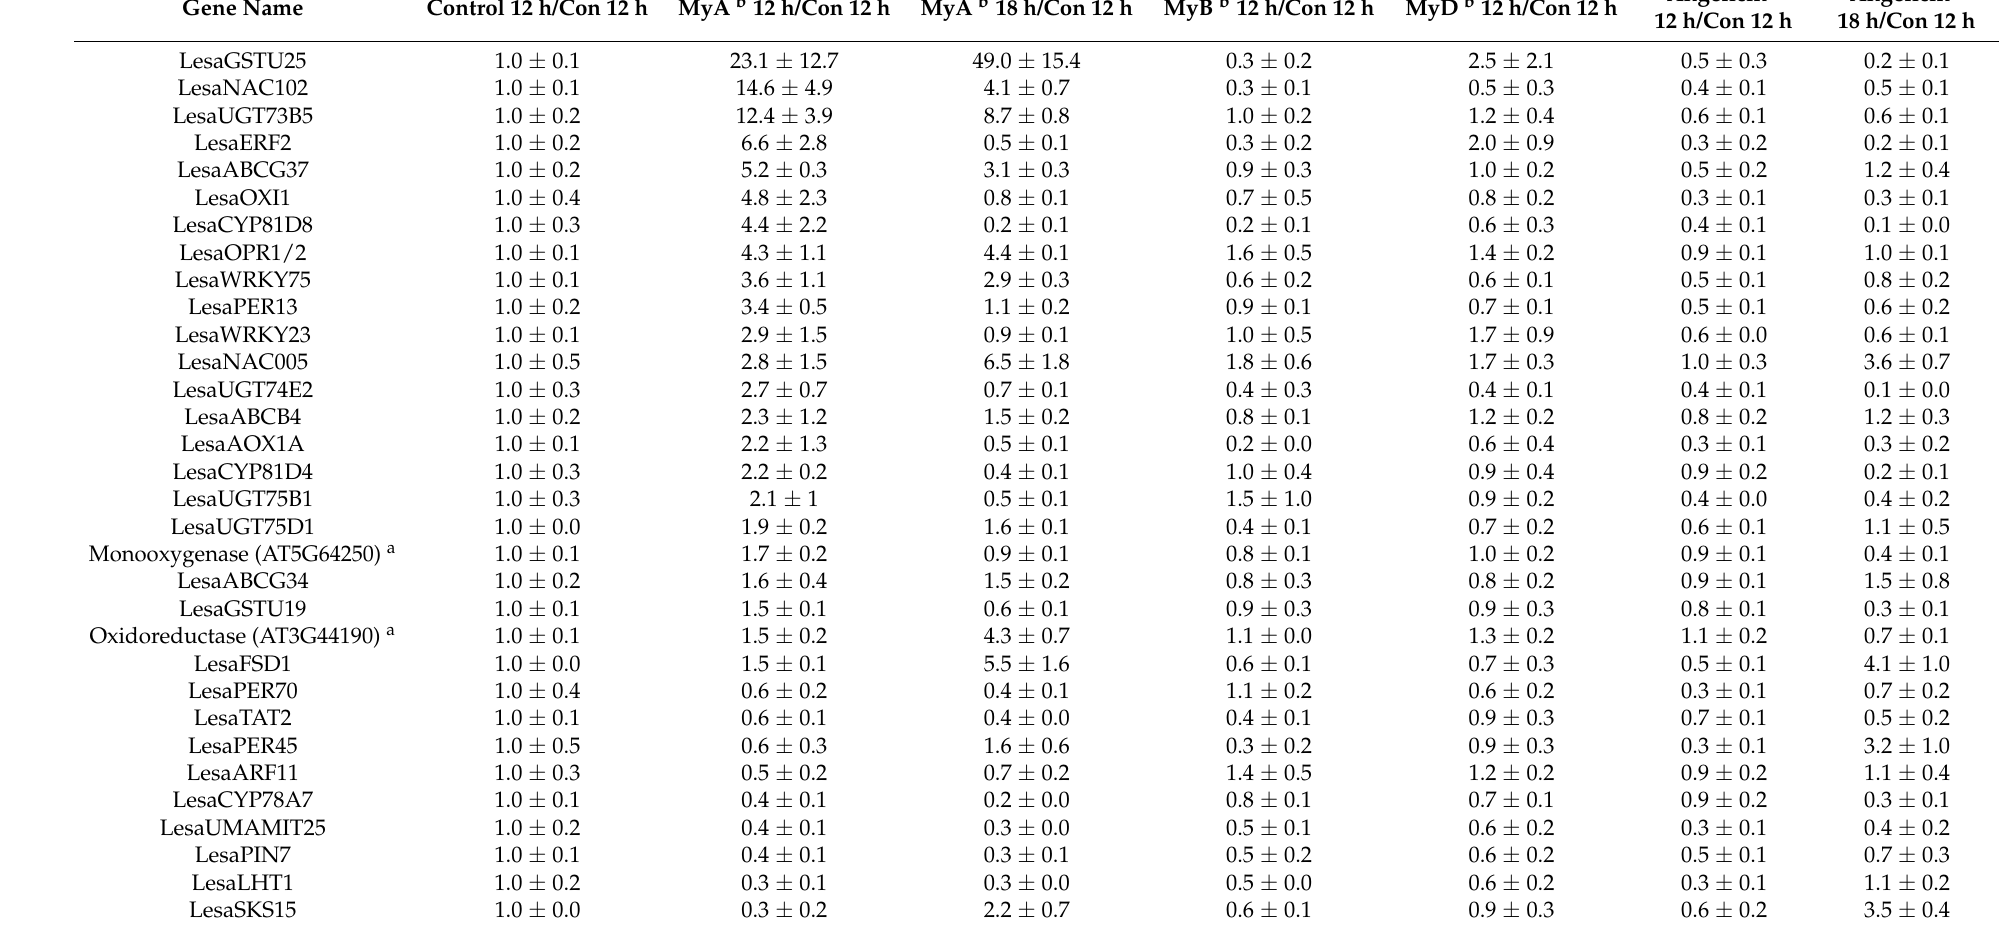
Table 2. Comparison of compound treatment on the expression of selected genes in germinating Lepidium sativum ( Lesa ) seeds. Normalised RT-qPCR ratios (compound/control at the times indicated) for myrigalone A (MyA), MyB, MyD and angelicin treatments. Mean ± SEM from RNA extracted from three biological replicate